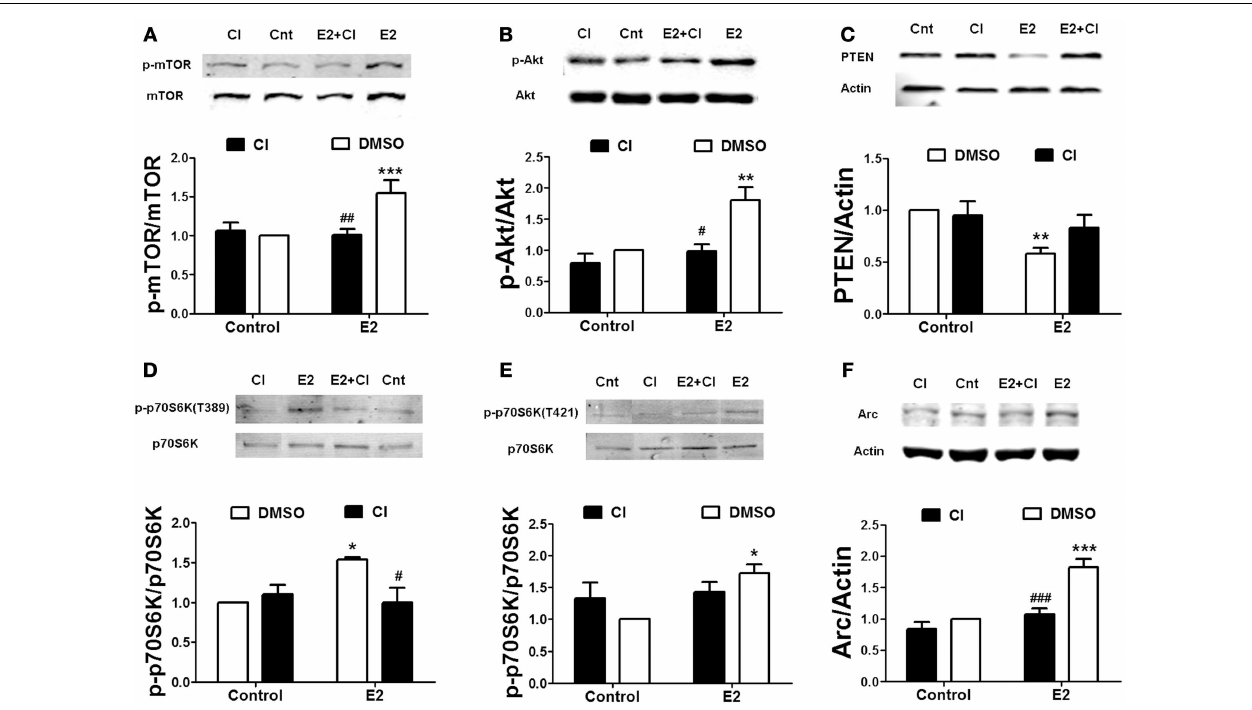
(fold of control) of: (A) p-mTOR over total mTOR ( N = 3–11), (B) p-Akt over total Akt ( N = 2–4), (C) PTEN over actin ( N = 5–8), (D) p-p70S6K (T389) over total p70S6K ( N = 3–4), (E) p-p70S6K (T421/S424) over total p70S6K ( N = 5), (F) Arc over actin ( N = 4–8); * p < 0.05, ** p < 0.01, *** p < 0.001, as compared to control (DMSO); # p < 0.05, ## p < 0.01, ### p < 0.001, as compared to E2 alone (two-way